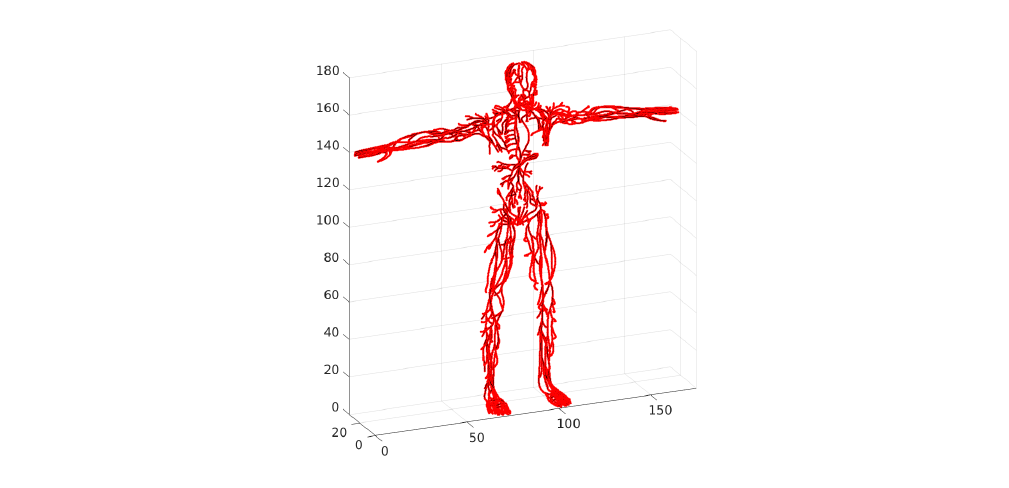
Figure 17. The uniform graph with equidistant vertices and edge lengths equal to 0.5 cm. Figure 18 shows the distribution of the vertex degree and the edge lengths for the uniform graph.